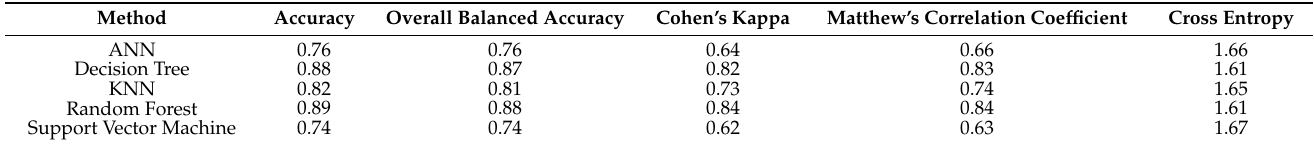
Table 3. Evaluation of the ANN, Decision Tree, KNN, Random Forest, and Support Vector Machine on the test dataset in terms of global